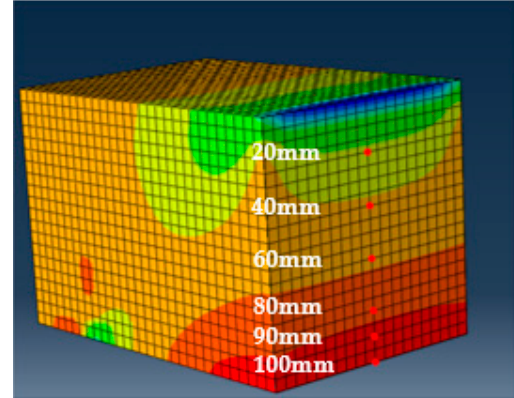
Figure 2. The position of the point in the model.